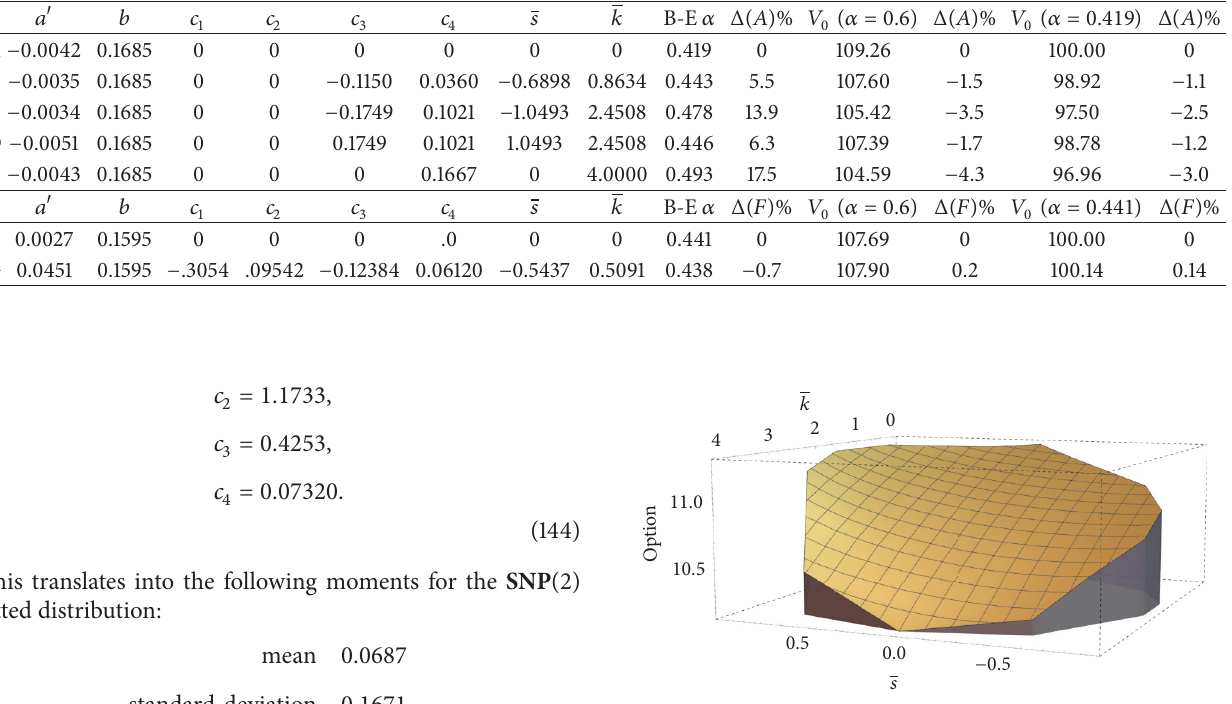
Figure 5: Lookback option prices as a function of skewness and excess